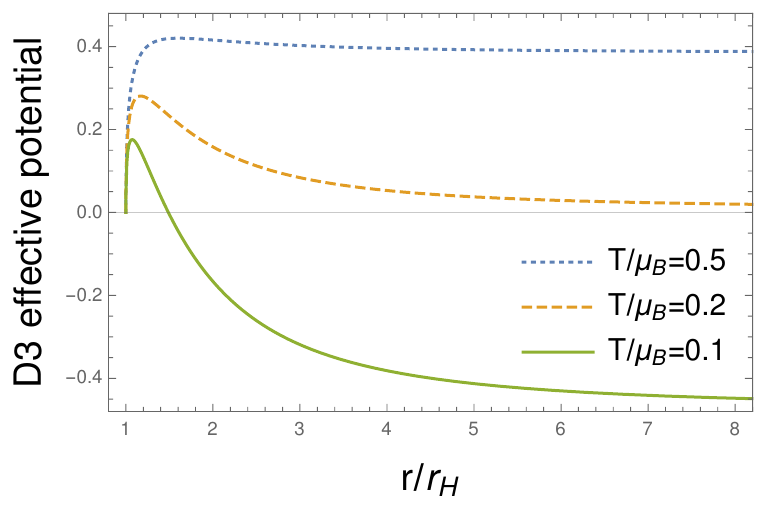
Figure 5 . The e(cid:11)ective potential for a probe color D3-brane at T=M = 0 : 5, with J =